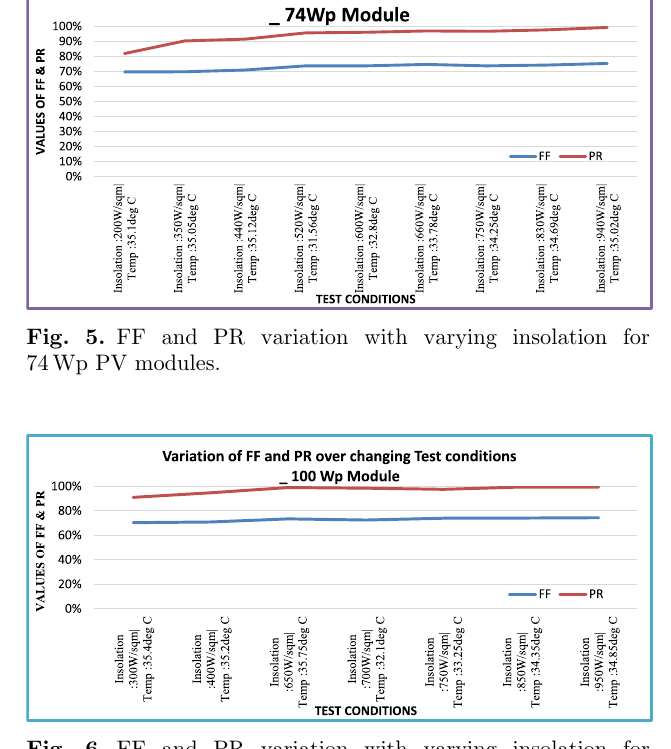
Fig. 6. FF and PR variation with varying insolation for 100 Wp PV modules.